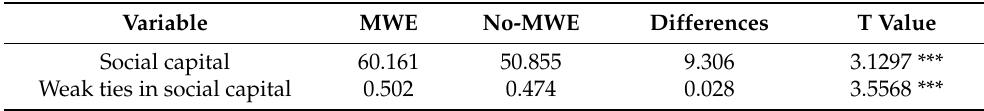
Table 3. The differences between sample groups with and without off-farm work experience. Variable MWE No-MWE Differences T Value Social capital 60.161 50.855 9.306 3.1297 *** Weak ties in social capital 0.502 0.474 0.028 3.5568 ***